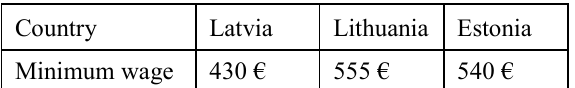
Table 2. Monthly Minimum Wage in the Baltic States (EUR)